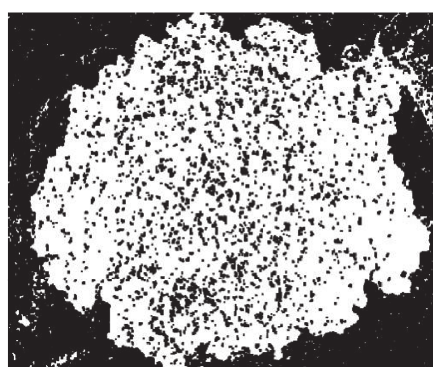
Figure 6: Image processed by dilation, erosion, and median